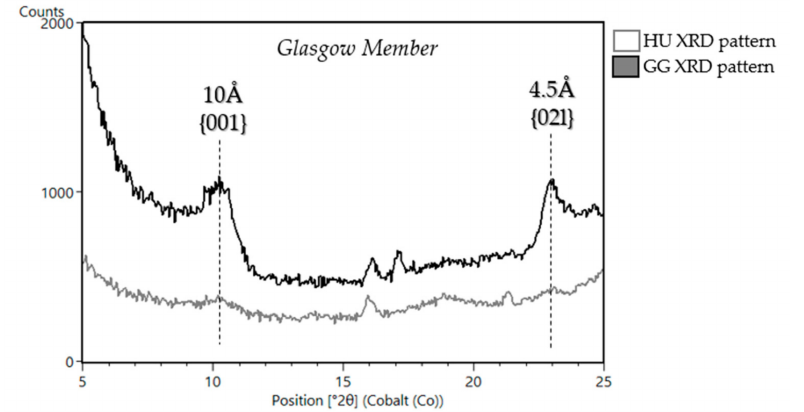
Figure 18. CheMin XRD patterns of the Glasgow member. The basal d-spacing peaks of the 001 of 10 Å and 02l of 4.5 Å are denoted by dashed black lines. A pronounced 10 Å peak is seen in the GG pattern and these samples are a topic of discussion of an upcoming